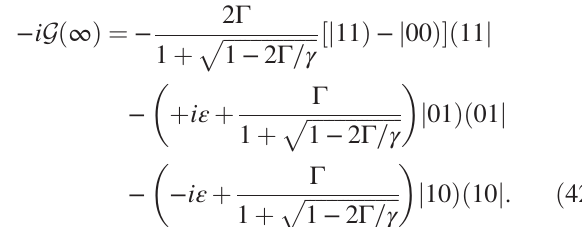
ffiffiffiffiffiffiffiffiffiffiffiffiffiffiffiffiffiffi p 1 − 2 Γ = γ